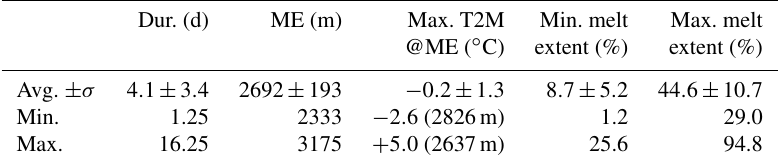
Table 2. Average, minimum, and maximum of melt event duration (Dur.), of maximum elevation experiencing surface melt (ME), and of maximum 2m temperature (T2M) at this highest grid point as well as of minimum and maximum melt extent during the event. For T2M@ME, the elevation at which it was observed is indicated in brackets. The total number of melt events is N = 77. Dur. (d) ME (m) Max. T2M